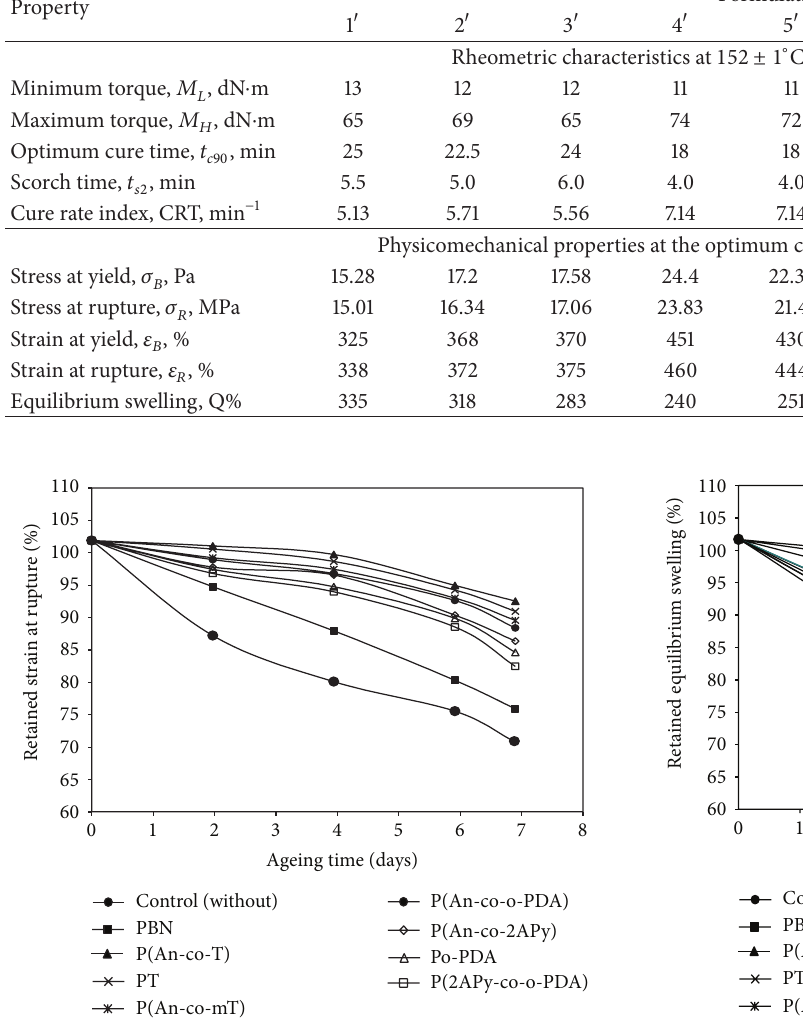
Figure 5: Retained stress at rupture versus ageing time for SBR